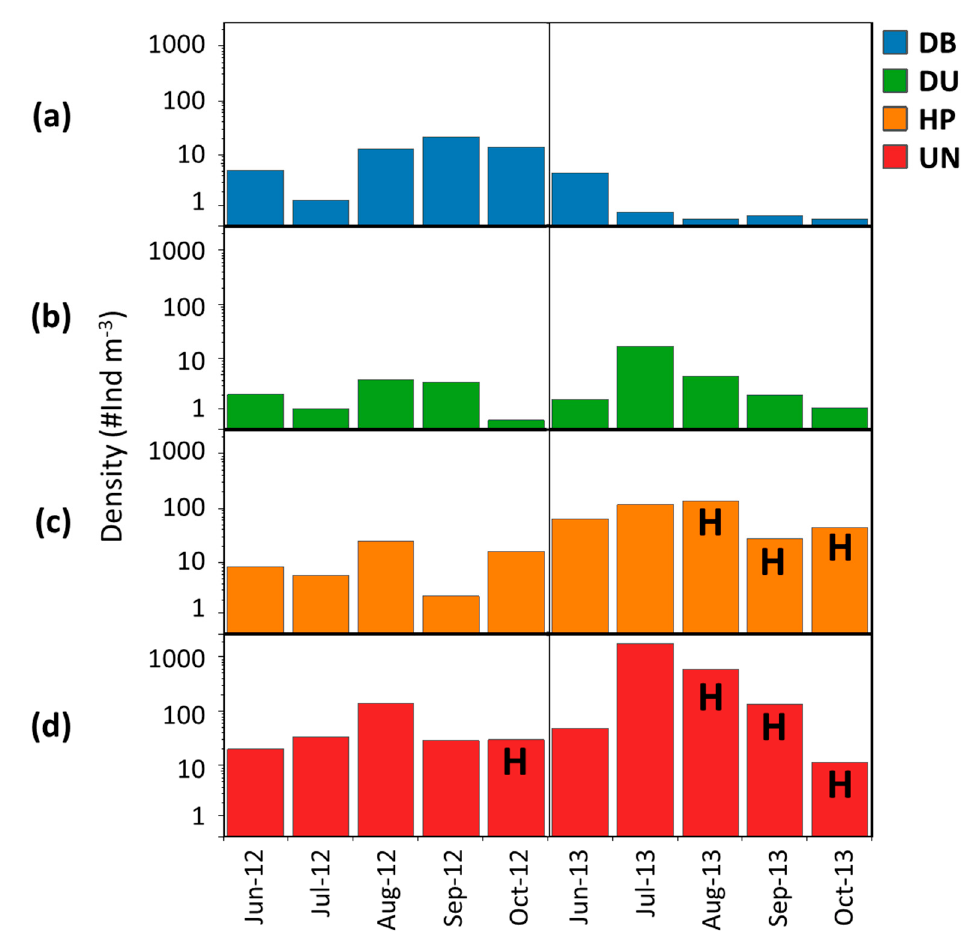
Figure 4. Total mesoplankton jellyfish abundances (Ind m − 3 ) at four stations in Hood Canal ( a ) Dabob, ( b ) Duckabush, ( c ) Hoodsport, and ( d ) Union during June through August 2012 and 2013, colored by station. ‘H’ indicates stations with bottom-water or mid-layer hypoxia ( ≤ 2.0 mg DO L − 1 ).